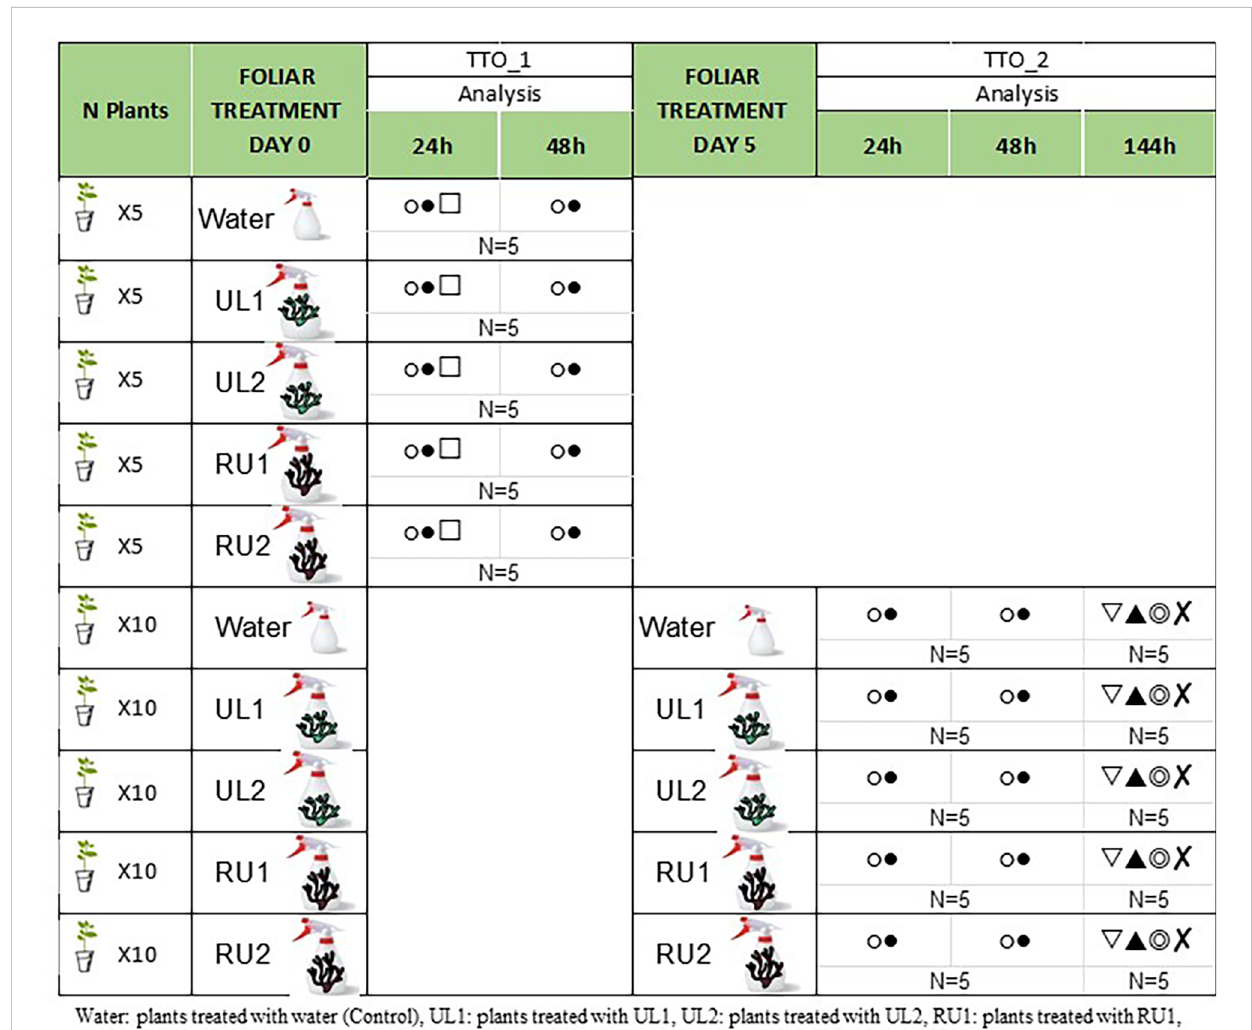
FIGURE 1 Experimental